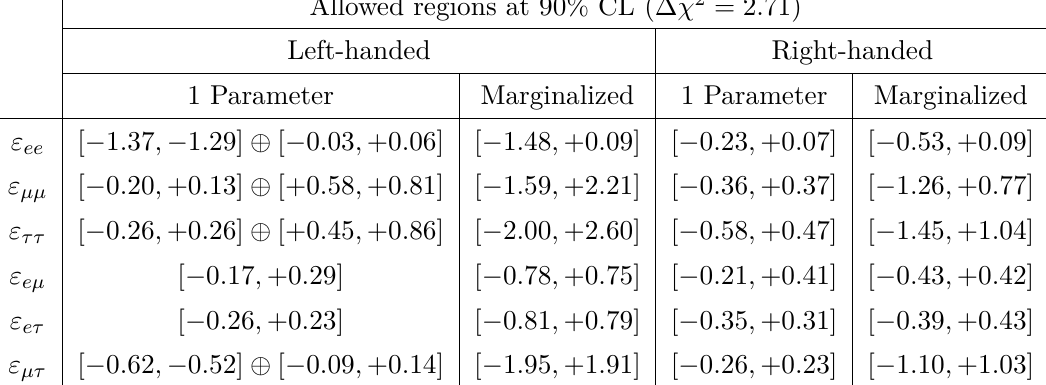
Allowed regions at 90% CL (∆ χ 2 = 2 . 71) Left-handed Right-handed 1 Parameter Marginalized 1 Parameter Marginalized